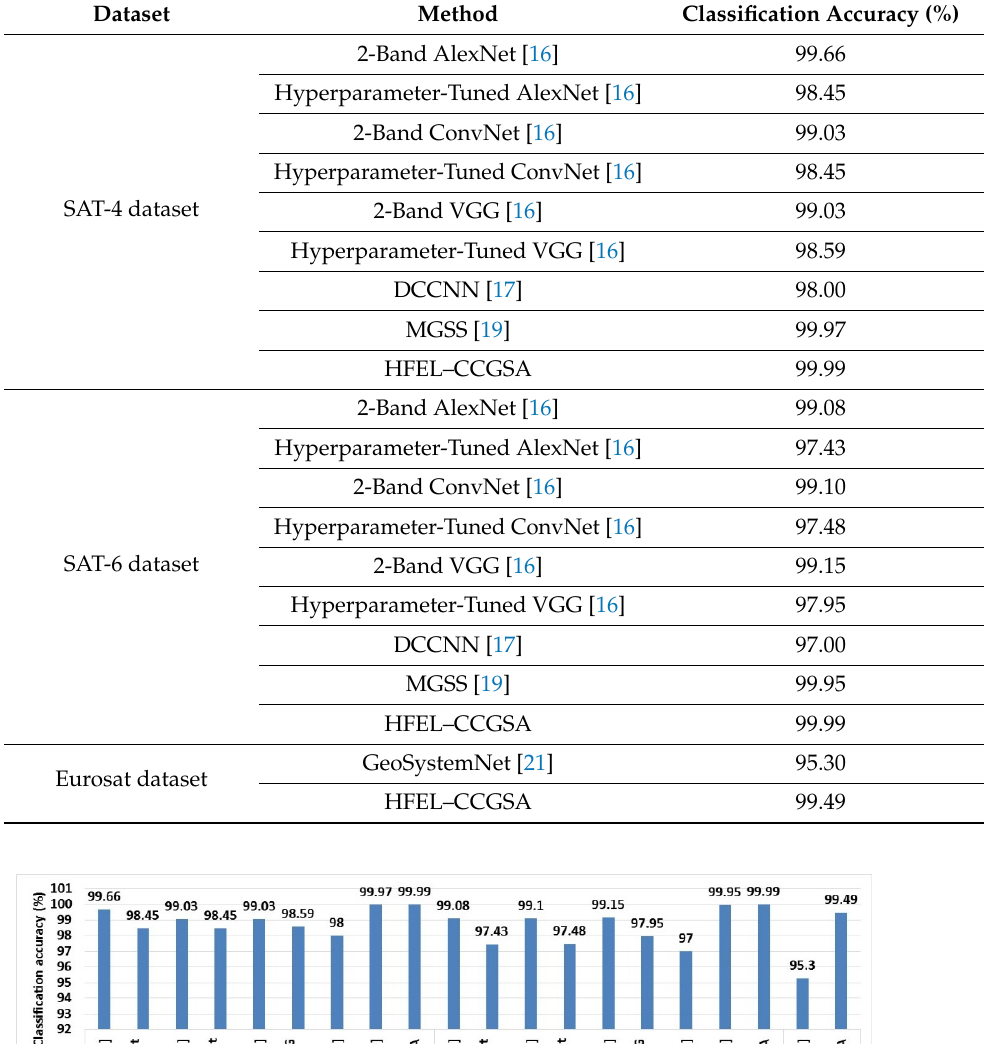
Table 10. Comparative analysis of HFEL–CCGSA method on 5-fold cross-validation.